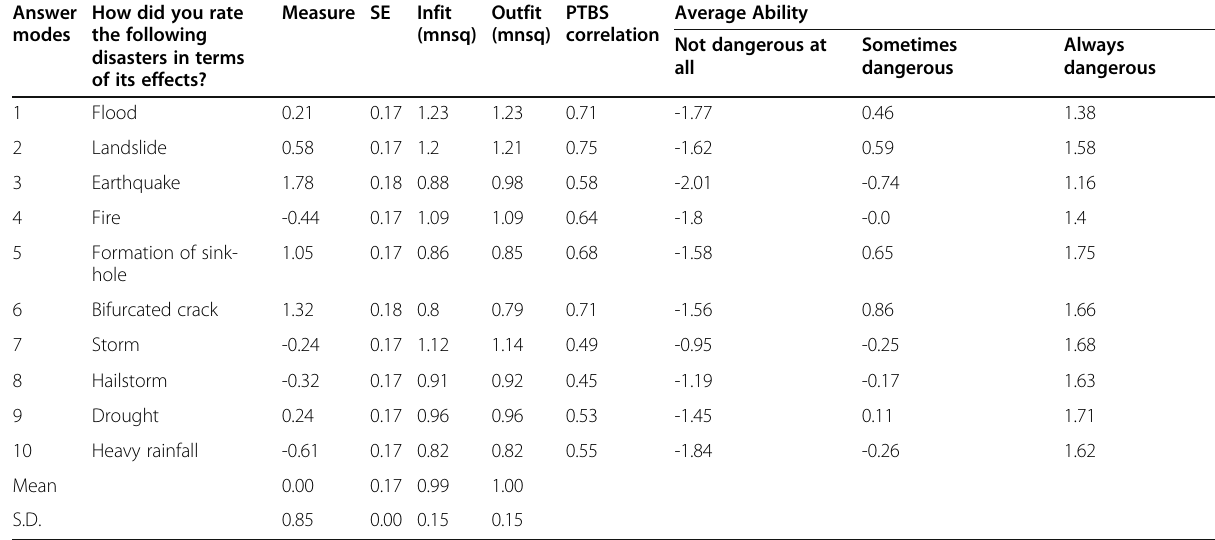
Table 9 Partial Credit Model on perception of disaster risk scale measurements through a question related to major disasters and feeling of dangerous Answer How did you rate modes the following disasters in terms of its